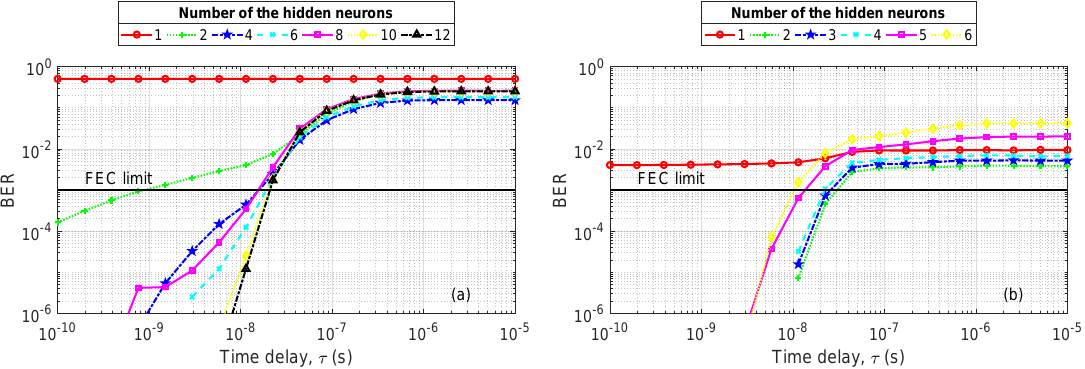
Figure 3. The BER in terms of the time delay with the number of hidden neurons as the parameter for ( a ) the real ELM with the sigmoid mapping function and ( b ) the complex ELM with the tanh mapping